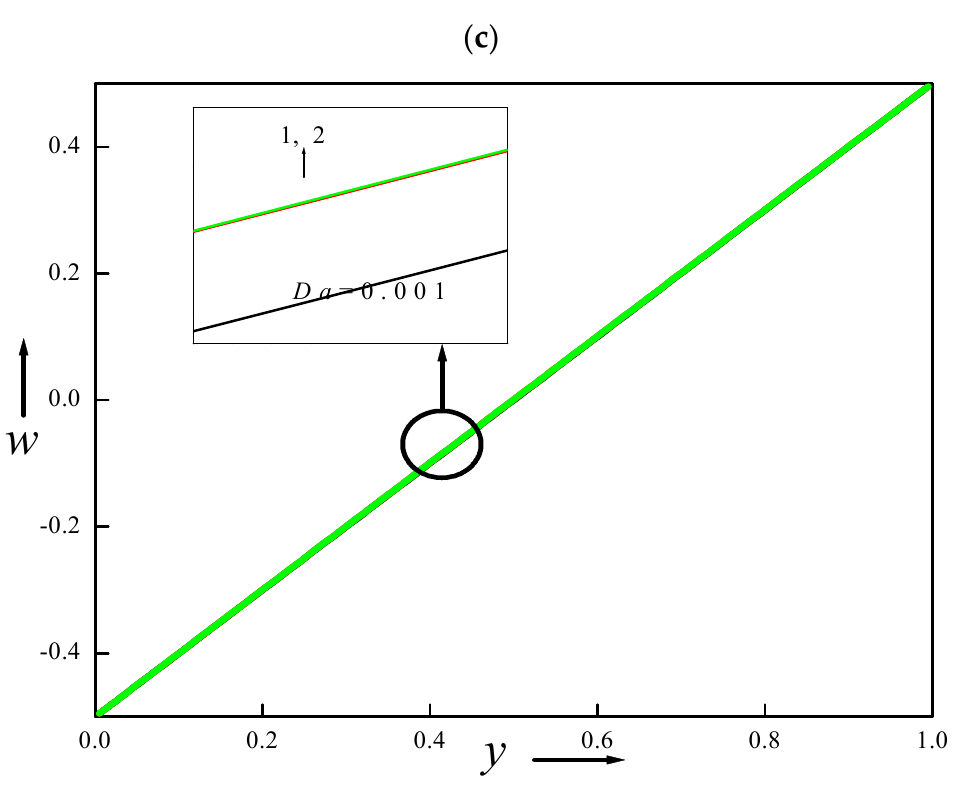
Figure 5. Velocity ( a ) contours, ( b ) profiles, and ( c ) temperature profiles for altered Darcy number.